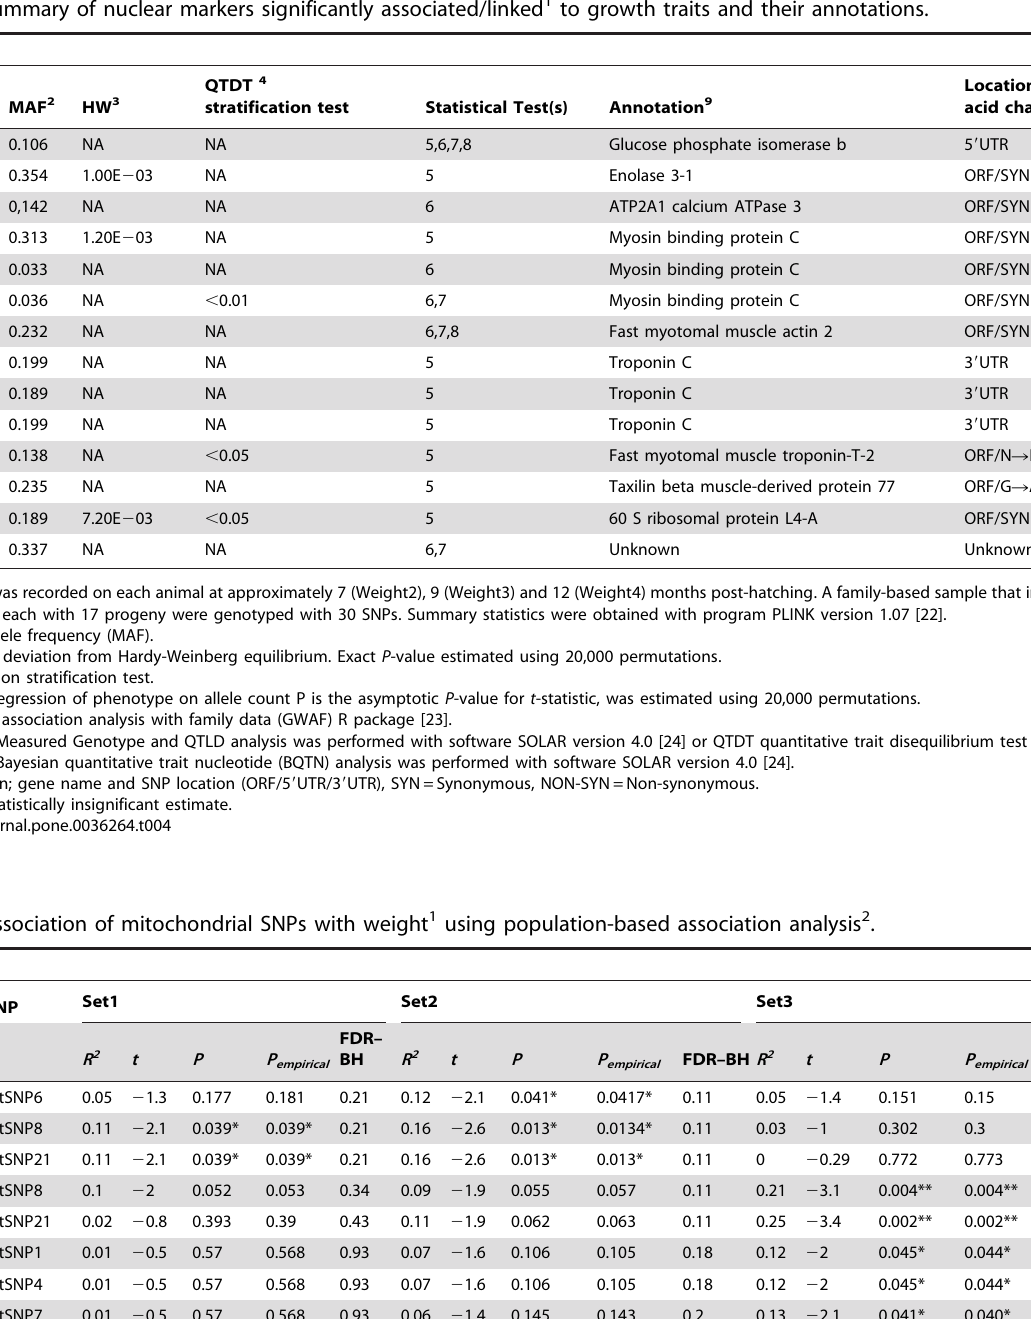
Table 4. Summary of nuclear markers significantly associated/linked 1 to growth traits and their annotations.